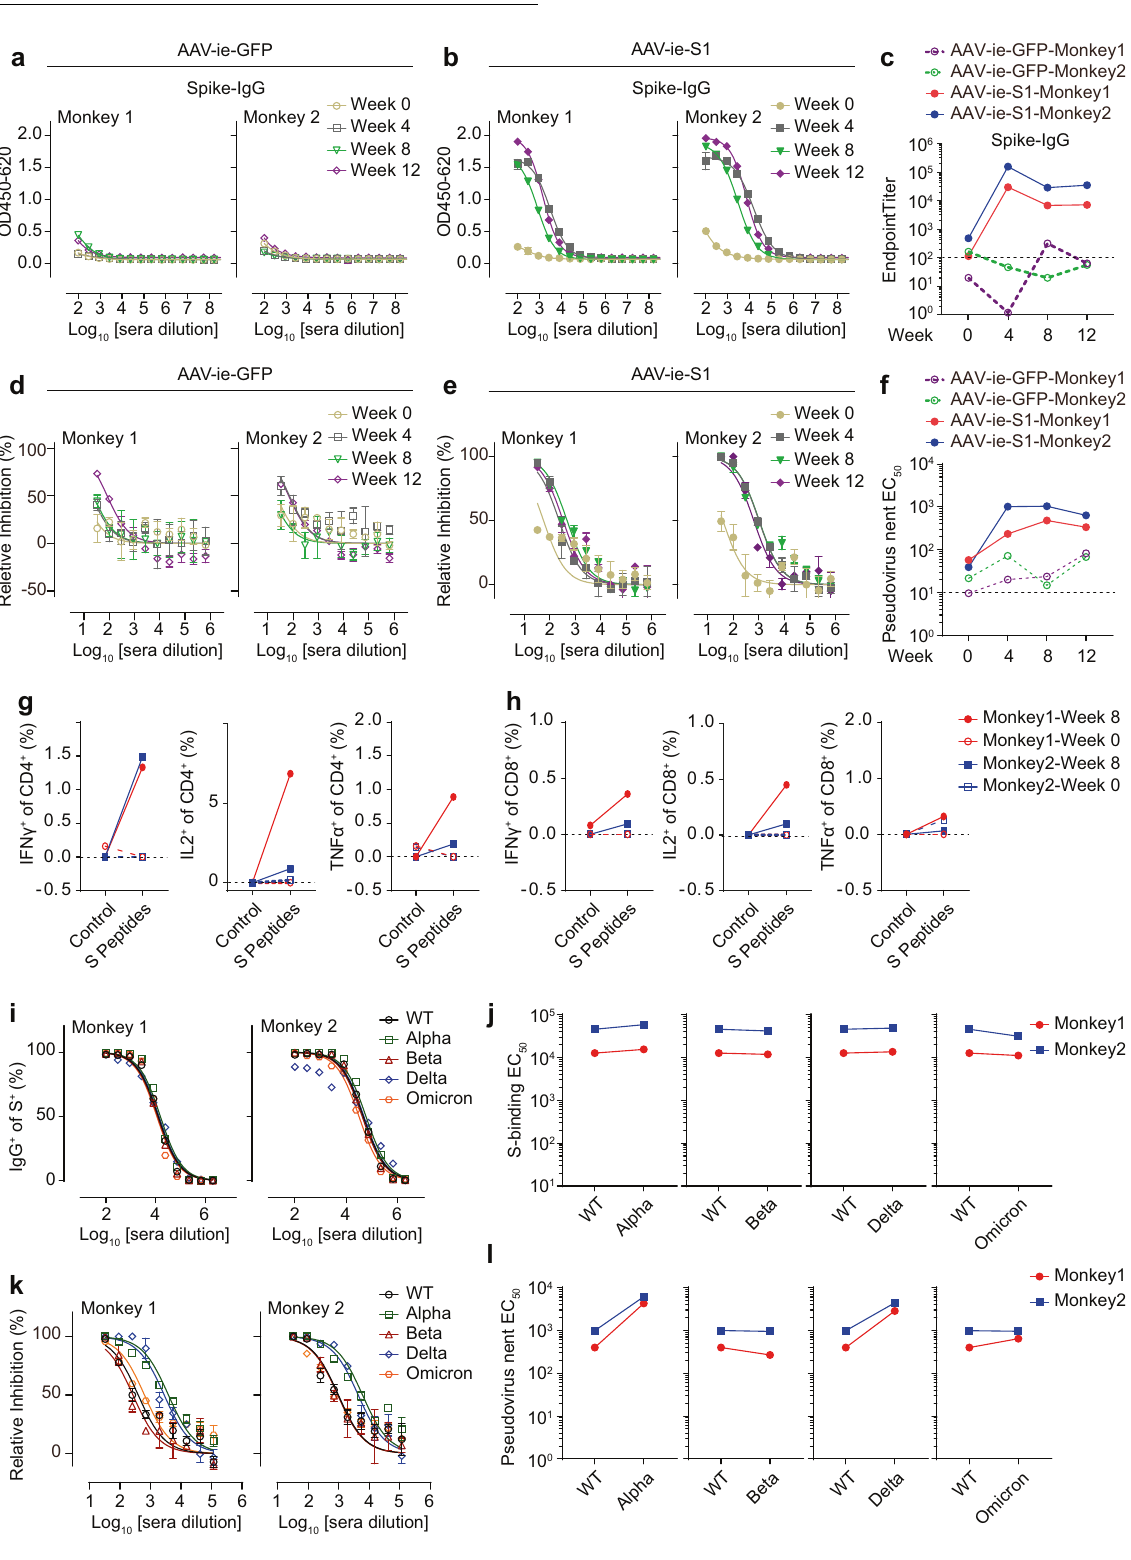
observed (Supplementary Fig. S8). The pseudo-virus neutralizing EC 50 values of monkey 1 immune sera were determined as 236, 482, and 337 on week 4, 8, and 12, respectively; the neutralizing EC 50 values of monkey 2 immune sera were determined as 1017,